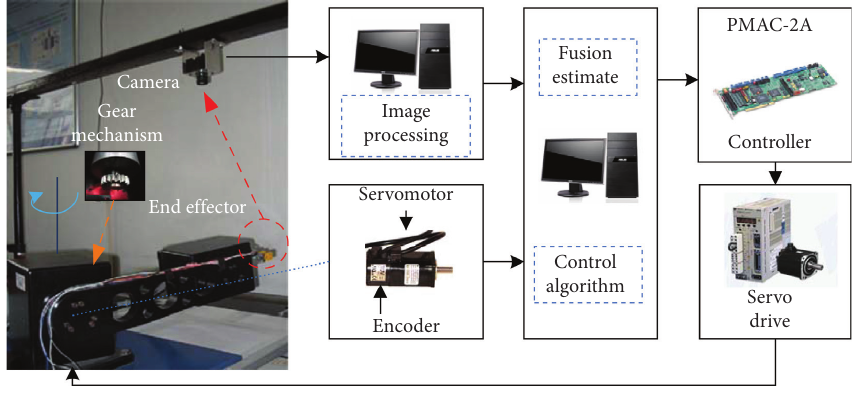
Figure 8: The experiment setup.